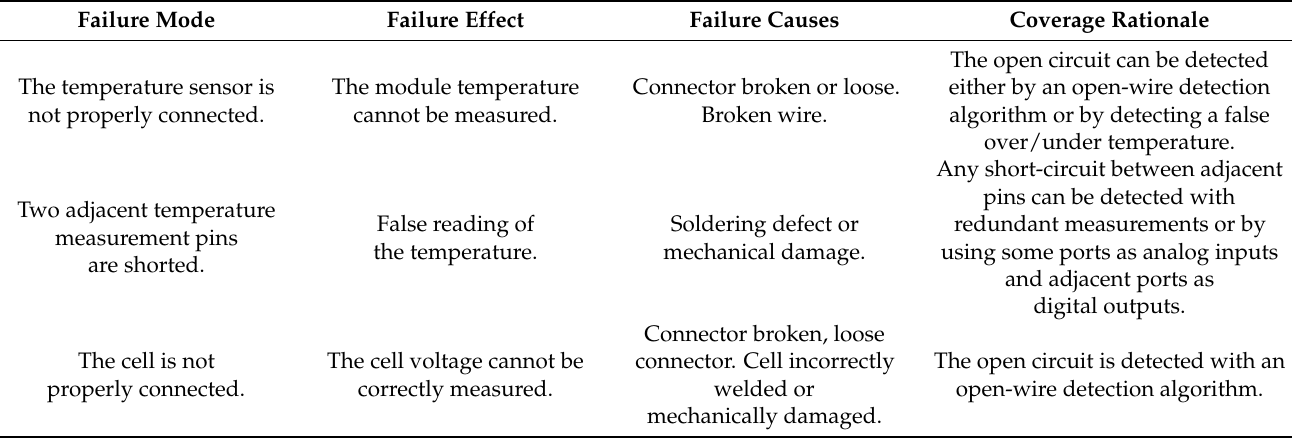
Table 6. Failure Modes and Effects Analysis (FMEA) of the enhanced BMS Slave. Failure